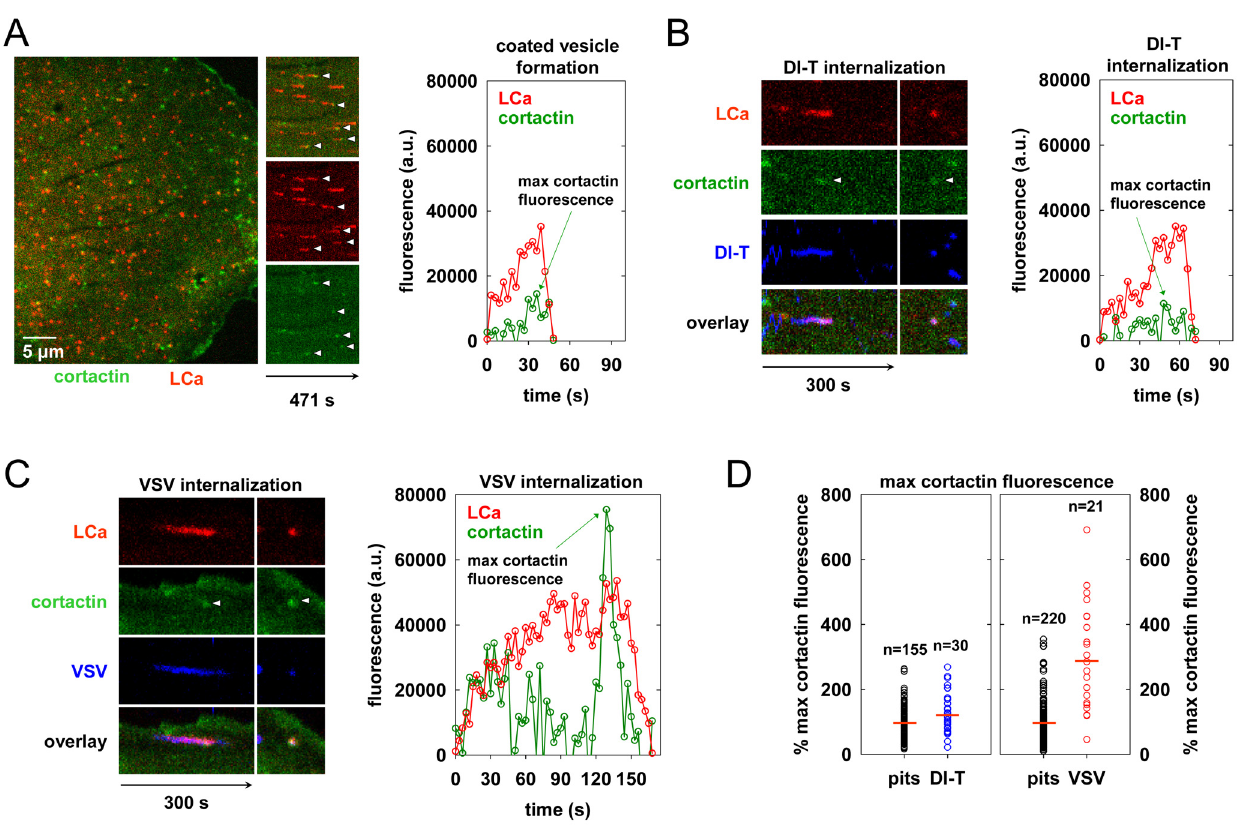
Figure 5. Clathrin structures containing VSV recruit more cortactin that pits that internalize DI-T. (A) Cortactin recruitment during coated pit formation. Left, snapshot showing the surface of a BSC1 cell transiently expressing cortactin-eGFP (green) and mCherry-LCa (red) at 18 h post-transfection. Time-lapse images were acquired at 3 s intervals, and frame 83 is shown. Middle, split channel kymographs of coated pit formation in the cell at left. White arrowheads highlight pits in which cortactin recruitment is clearly visible above the local background. Right, example plot of cortactin and clathrin fluorescence intensity over time during the formation of a single clathrin-coated pit in the cell shown at left (Video S5). (B and C) Examples of cortactin recruitment during DI-T (B) and VSV (C) uptake. BSC1 cells transiently expressing mCherry-LCa (red) and cortactin-eGFP (green) were inoculated with Alexa Fluor 647-labeled DI-T or VSV, and images were acquired as in A. Left, split-channel kymograph views of protein and virion (blue) fluorescence intensity over time (Videos S6, S7). Images in the right-hand panels show a snapshot of the maximal cortactin or clathrin fluorescence, and white arrowheads highlight the peak cortactin signal. Right, plots of the cortactin and clathrin fluorescence intensity over time for each internalization event. (D) Relative peak fluorescence intensity of cortactin in cells co-expressing mCherry-LCa and cortactin-eGFP. At 18 h post-transfection, samples were separately inoculated with DI-T or VSV particles, and images were acquired as in A. For each cell that was imaged, the maximum cortactin fluorescence associated with , 50 pits lacking virus particles (pits, black) and all pits that internalized a DI-T (left, blue, 3 cells) or VSV (right, red, 5 cells) particle was measured. The data are plotted as described in the legend of Figure 3C, and the number of events is shown above each plot. Numerical values and statistical analyses are provided in Table